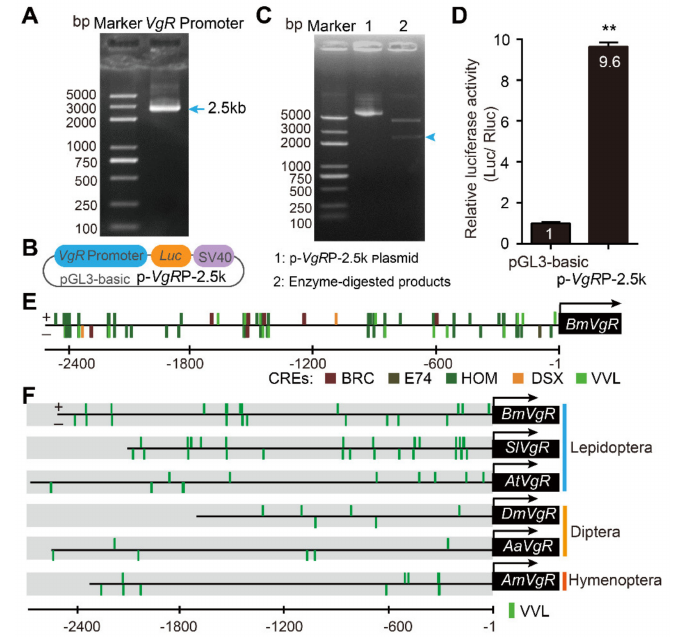
Figure 1. Analysis of the upstream regulatory region of the vitellogenin receptor ( VgR ) gene. ( A ): Clone of the upstream regulatory region of the Bombyx mori ( BmVgR ) gene. ( B ): Schematic diagram of the BmVgR promoter reporter vector. ( C ): Verification the BmVgR promoter reporter vector by enzyme digestion of Sma I and Hind III. ( D ): Activity verification of the BmVgR promoter by a dual luciferase reporter assay. The promoter activity is represented as fold-change compared to the control vector (pGL3-basic). ( E ): Diagram / Schematic of the cloned BmVgR promoter region, labeled with identified putative cis-response elements (CREs). Numbering of the upstream region sequence of the cloned BmVgR promoter is relative to the position of the translation start site ( + 1). Putative binding sites are: BRC, broad complex for ecdysone steroid response; E74, ecdysone induced protein E74A; HOM, homeodomain proteins; DSX, sex determination transcription factor doublesex; VVL, transcription factors with POU-domains. ( F ): Prediction of POU transcription factor cis-response elements (POU CREs) (VVL) in the VgR promoters of six insects. Sl , Spodoptera litura ; At, Amyelois transitella ; Dm, Drosophila melanogaster ; Aa, Aedes aegypti ; Am, Apis mellifera . The asterisks (**) represent significant di ff erences ( p < 0.01) detected using two-tailed Student’s t tests. Error bars indicate Standard Error of Mean (SEM) ranges ( n =